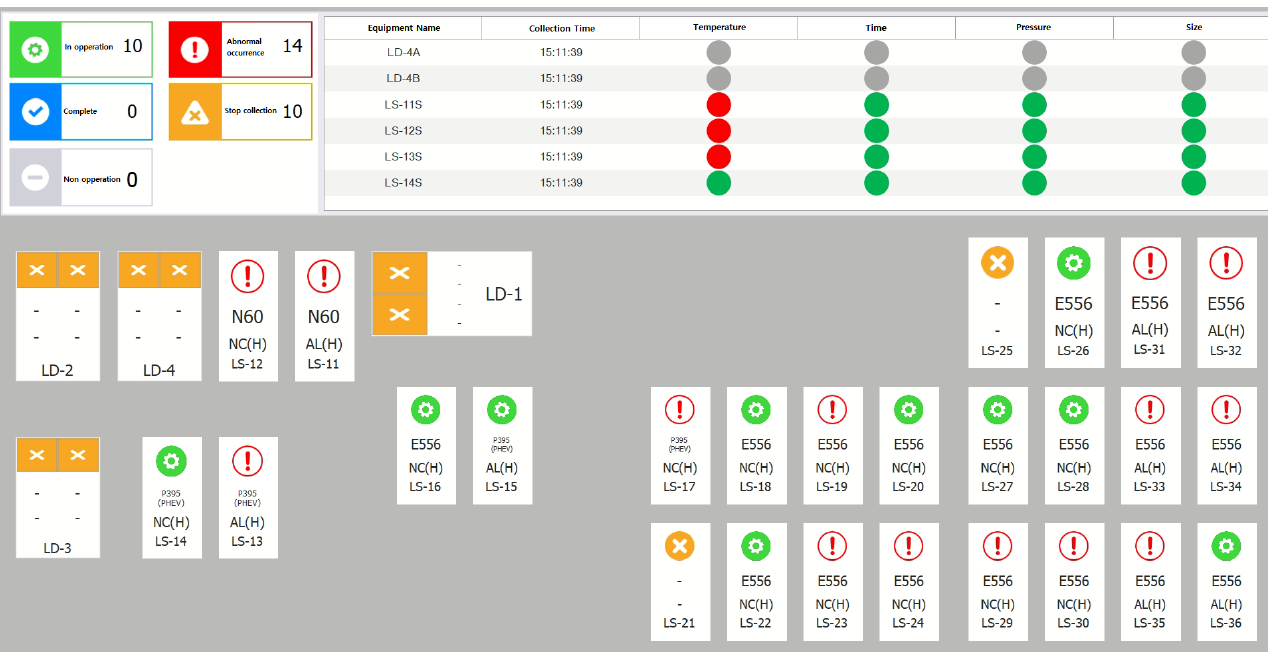
Figure 23. The operation/non-operation and abnormal occurrence management by